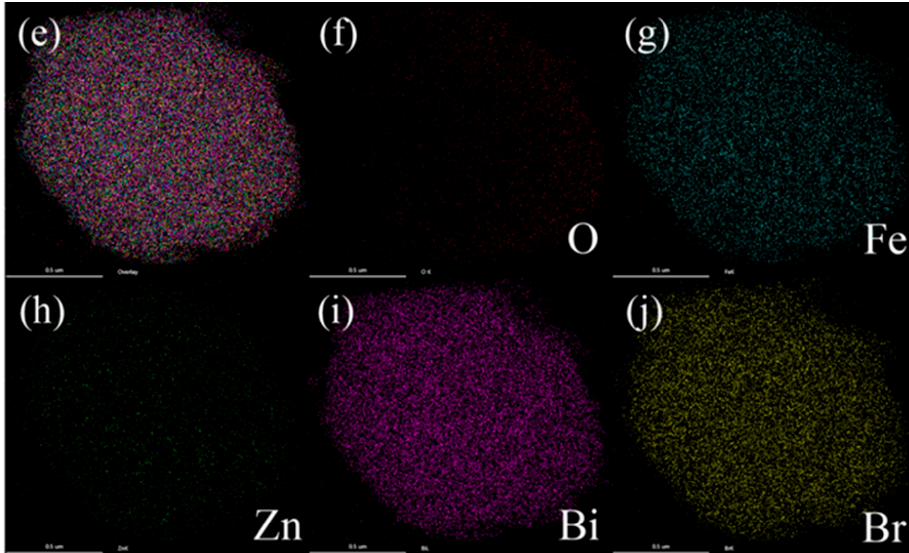
Figure 3. TEM images of ( a ) BOB/ZFO-10 heterojunction; ( b , c ) HRTEM images; ( d ) FFT transform image; and ( e – j ) element mapping images.